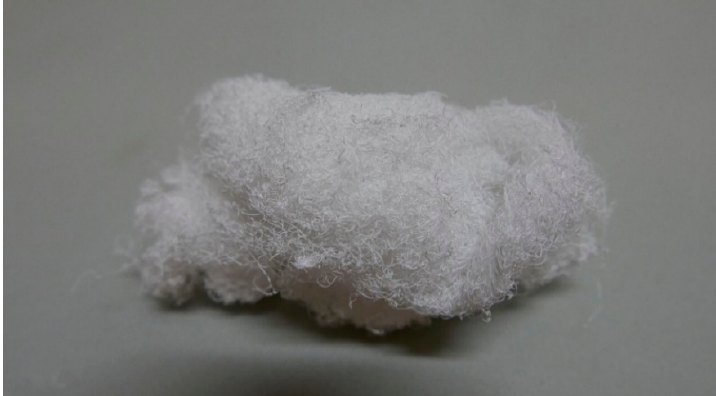
Figure 5. Photography of sample 3 wt.% and 3 ml.h − 1 detail.